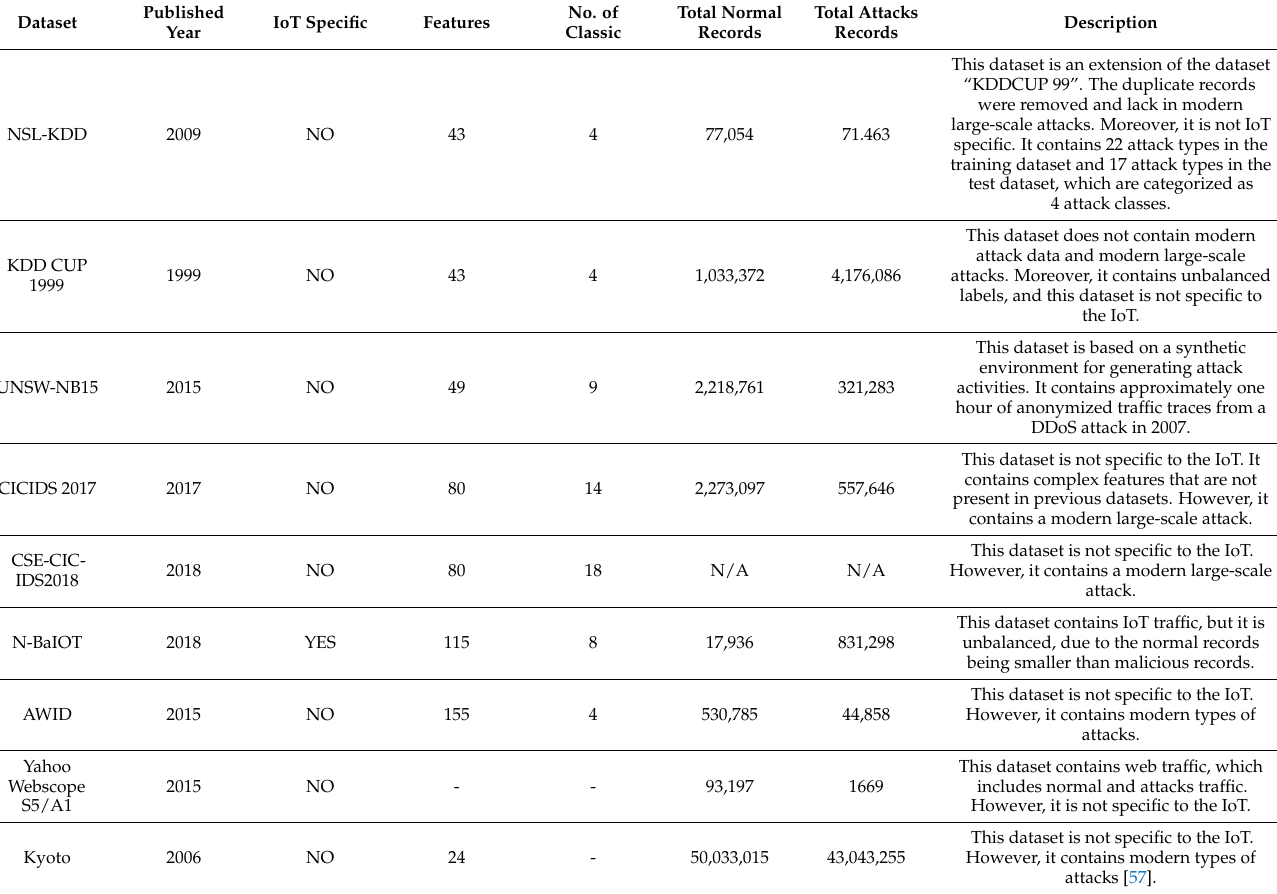
Table 7. The analysis of the most used datasets in the surveyed